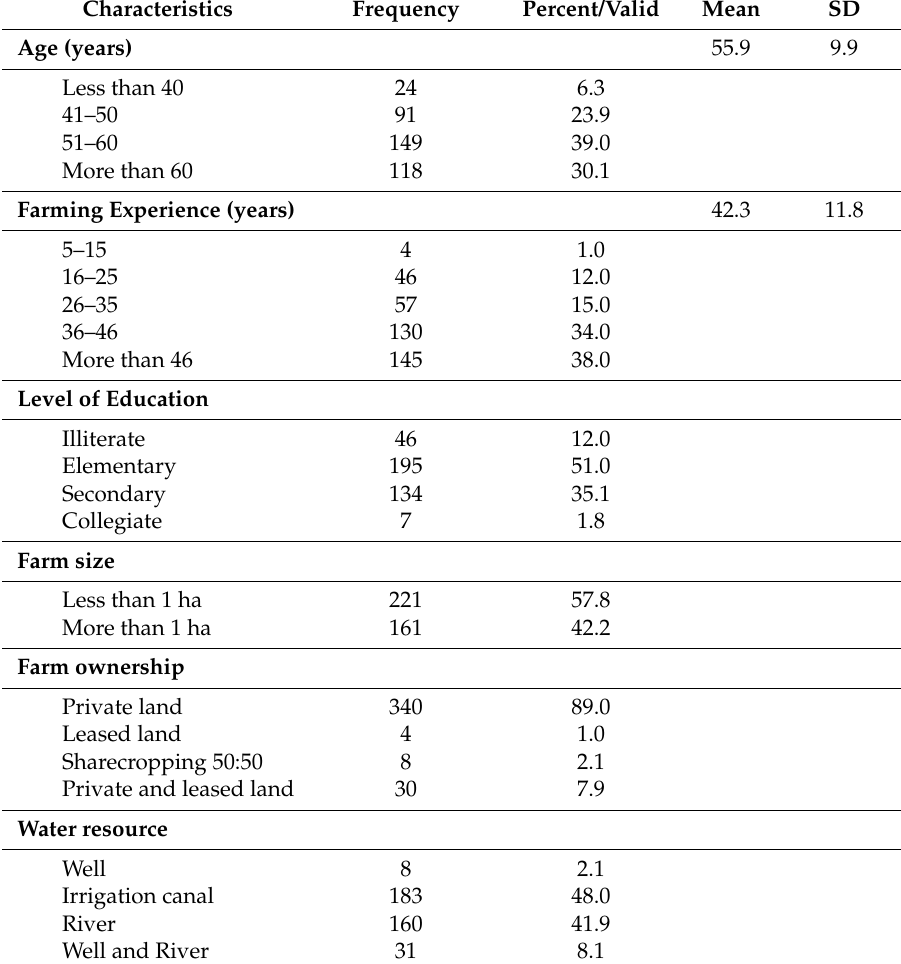
Table 3. Frequency distribution of farmers’ sociodemographic